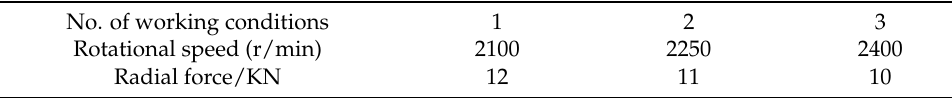
Table 2. Working conditions for accelerated life tests of bearings.